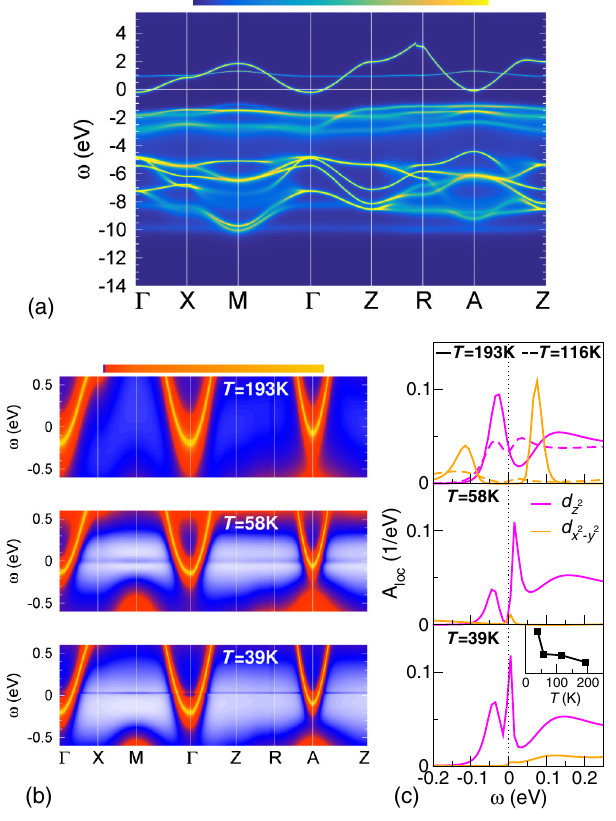
FIG. 2. Evolution of the DFT þ sicDMFT spectral data for NdNiO 2 with decreasing temperature. (a) k -resolved spectrum A ð k ; ω Þ along high-symmetry lines in the Brillouin zone over a wide energy range at T ¼ 193 K (from Ref. [11]). (b) Low- energy A ð k ; ω Þ for three different temperatures. (c) T -dependent Ni- d and Ni- d local spectral function A close to the loc z 2 x 2 − y 2 Fermi level. The small inset in the bottom part shows the two- orbital integrated spectral weight in the energy window ½ − 0 . 05 ; 0 . 05 (cid:2) eV.